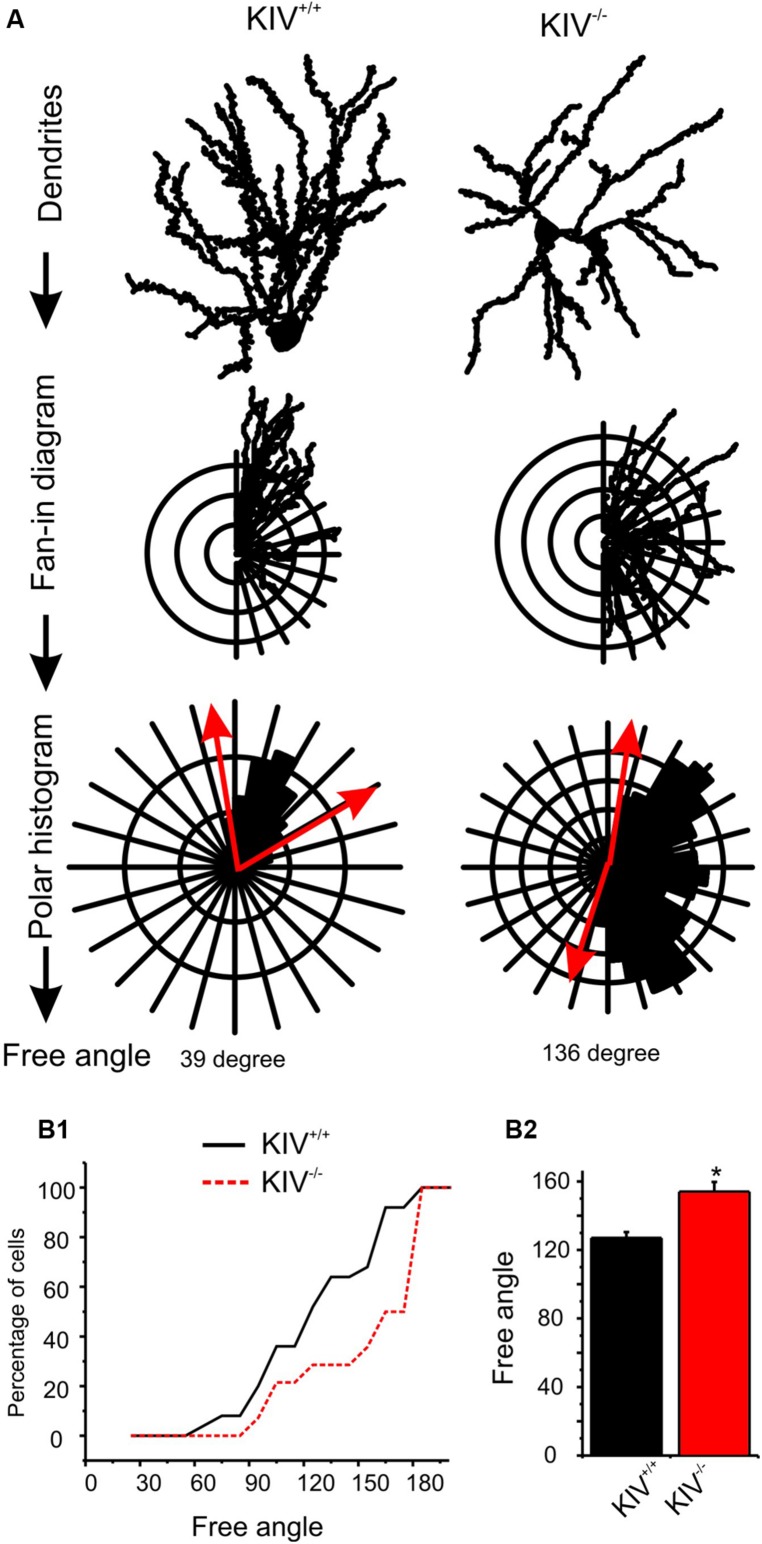
Altered dendritic asymmetry in KIV-/- mice. (A) Graphs illustrated the processes where the distribution of dendritic arbors was converted into a polar histogram, from which a free angle was derived. (B) Free angles, an objective way to assess the asymmetric feature of dendritic arbors, were significantly larger in KIV-/- mice (red, p < 0.05), indicating a reduced dendritic asymmetry.